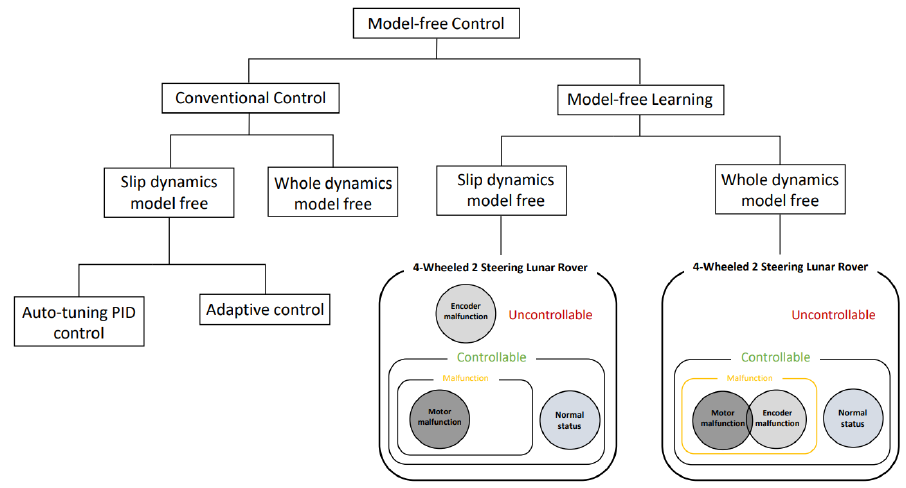
Figure 9. Controllability achieved by model-free learning during whole dynamics model-free con- trol.